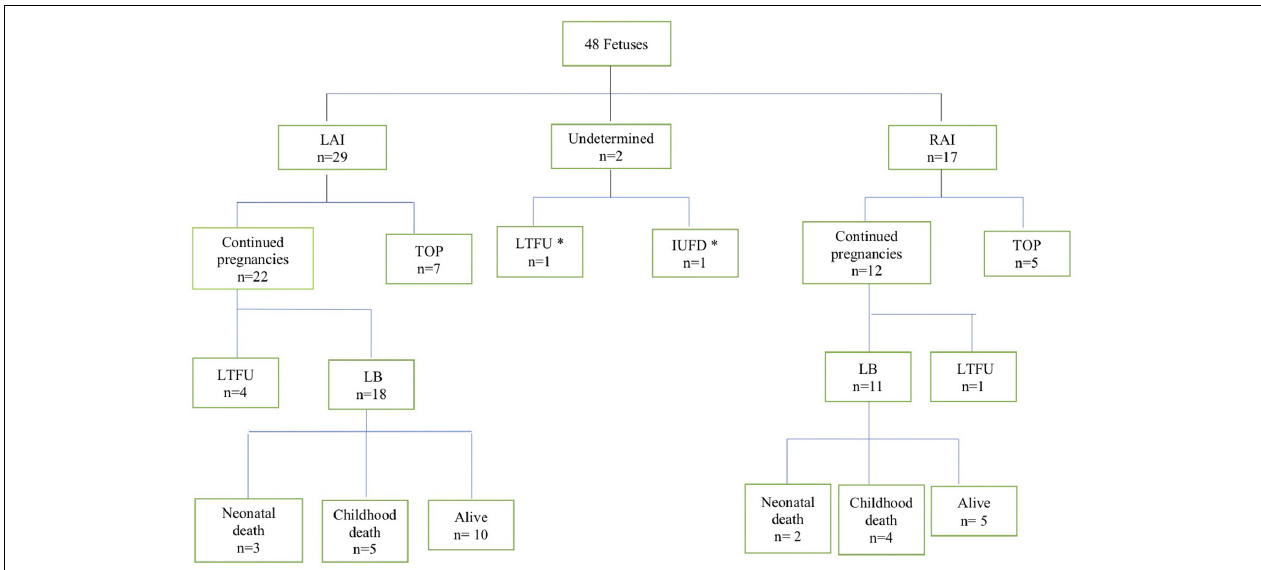
FIGURE 1 | Flowchart of patients with the pre-natal diagnosis of heterotaxy in this cohort. LAI, left atrial isomerism; RAI, right atrial isomerism; TOP, termination of pregnancy; LTFU, lost to follow up; IUFD, intrauterine fetal demise; LB, livebirth. ∗ These two fetuses were excluded from further analysis.